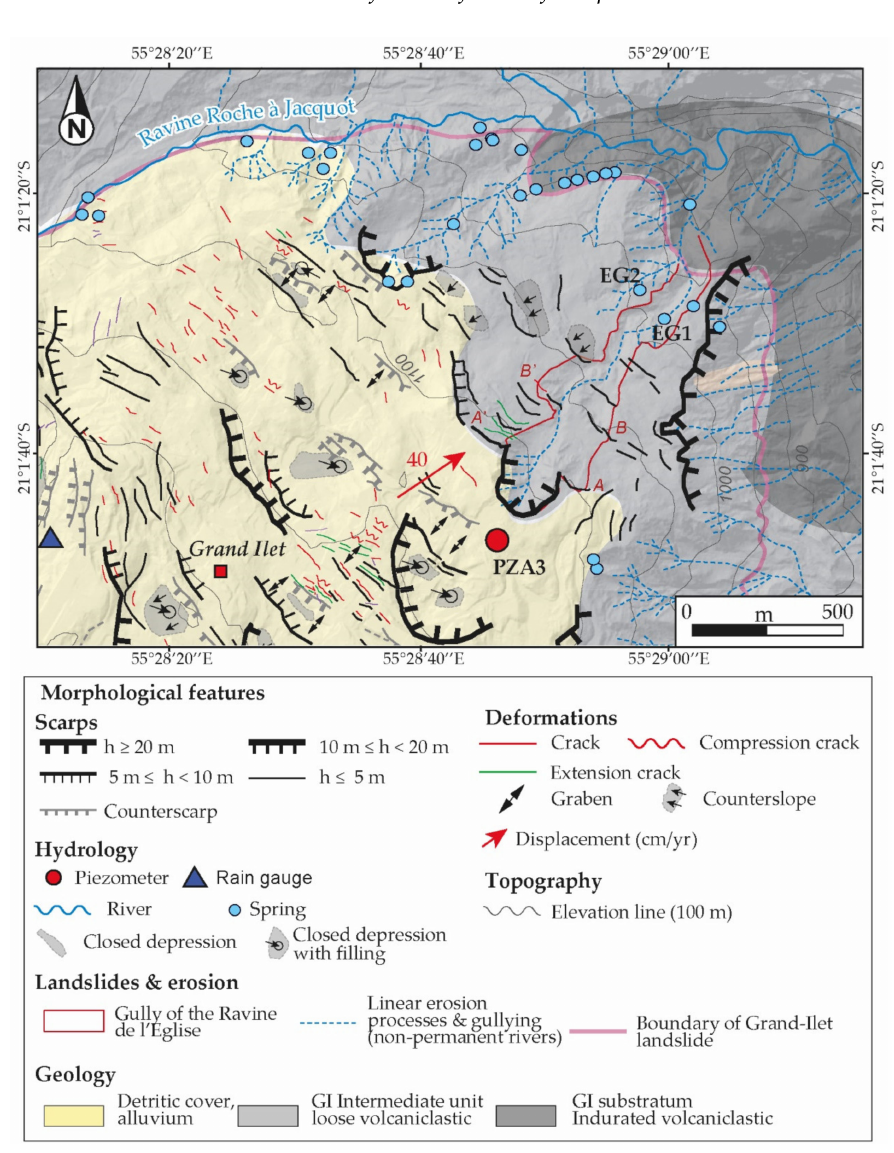
Figure 2. Geolo gical and morphological settings of the gully of the Ravine de l’Eglise. EG1 and EG2: springs; PZA3: piezometer; GI: Grand Ilet. Figure adapted from Rault et al., in review